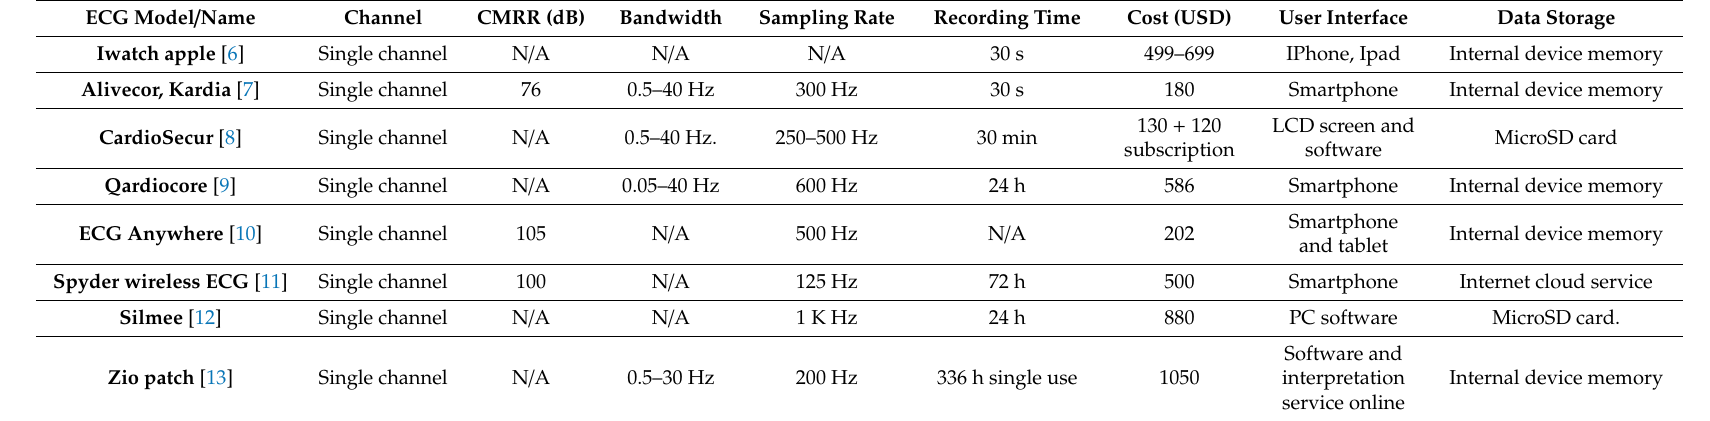
Table 1. Characteristics of modern mobile health electrocardiographs on the